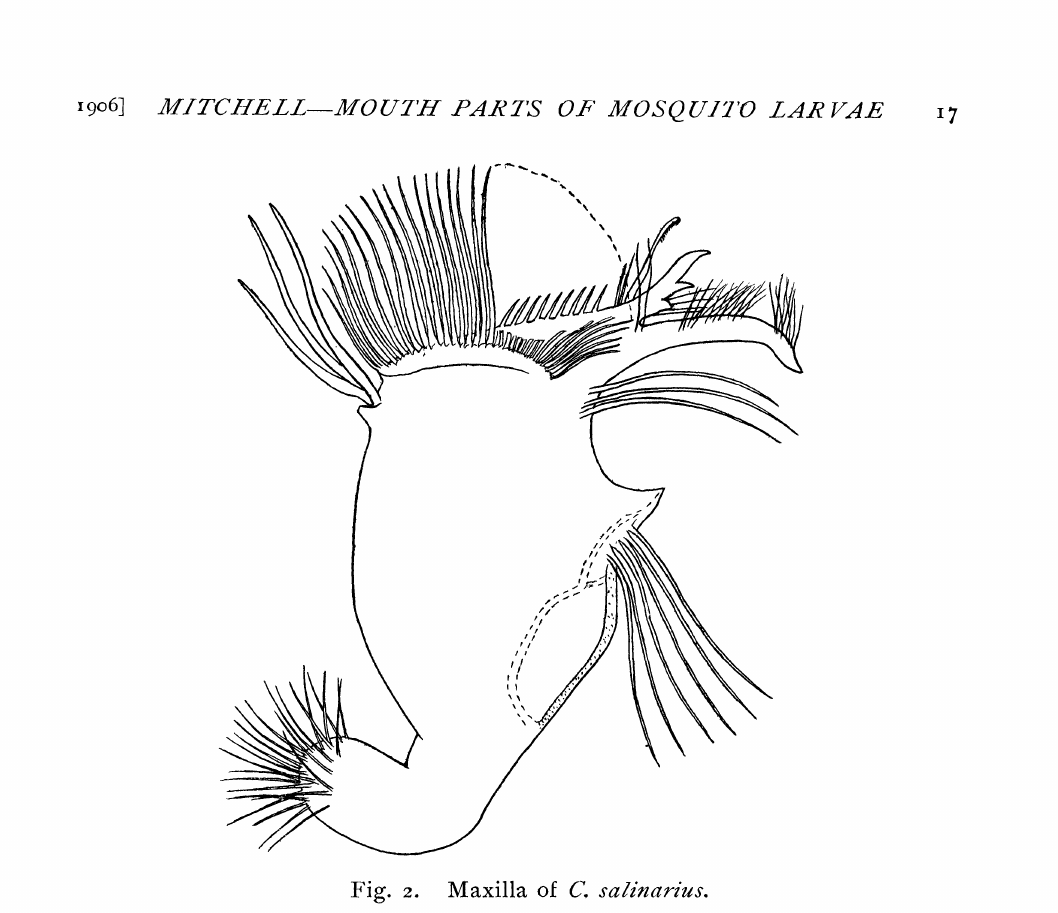
Fig. 2. Maxilla of C.